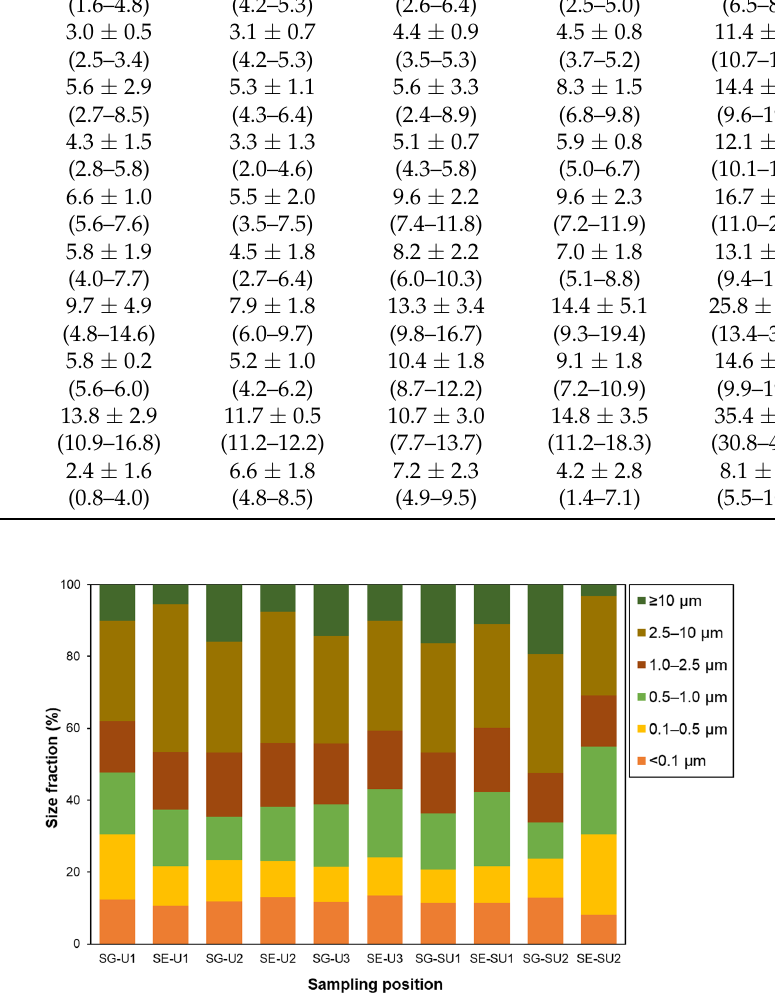
Figure 3. Average percentage of size fractions (particle size: <0.1 μ m, 0.1–0.5 μ m, 0.5–1.0 μ m, 1.0–